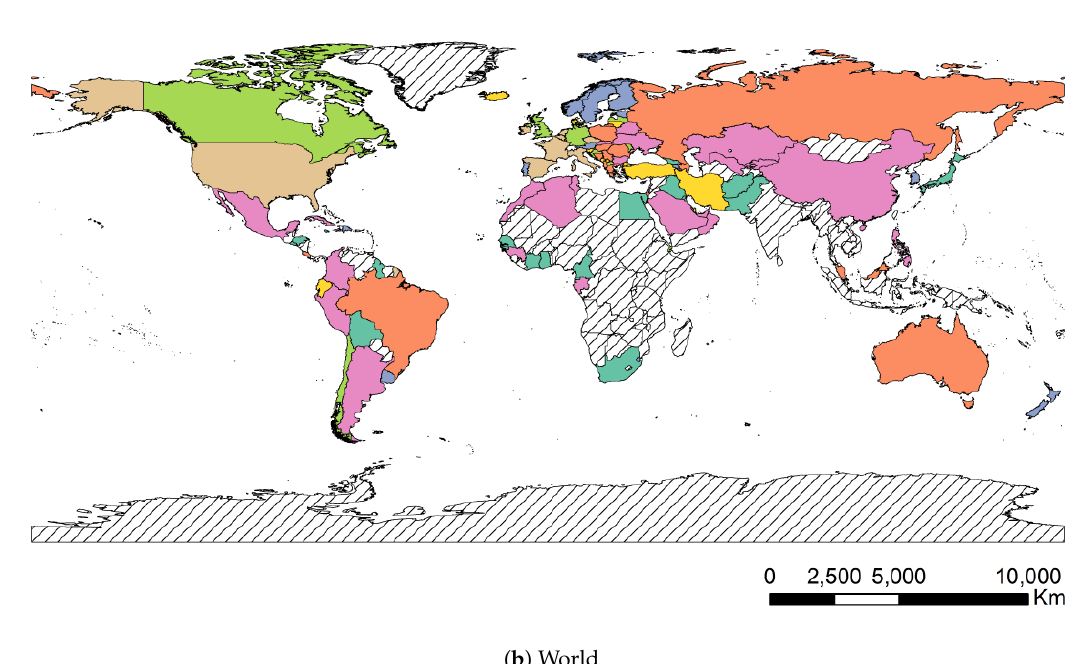
Figure 12. Clusters assignment of the different Brazilian states and world countries.